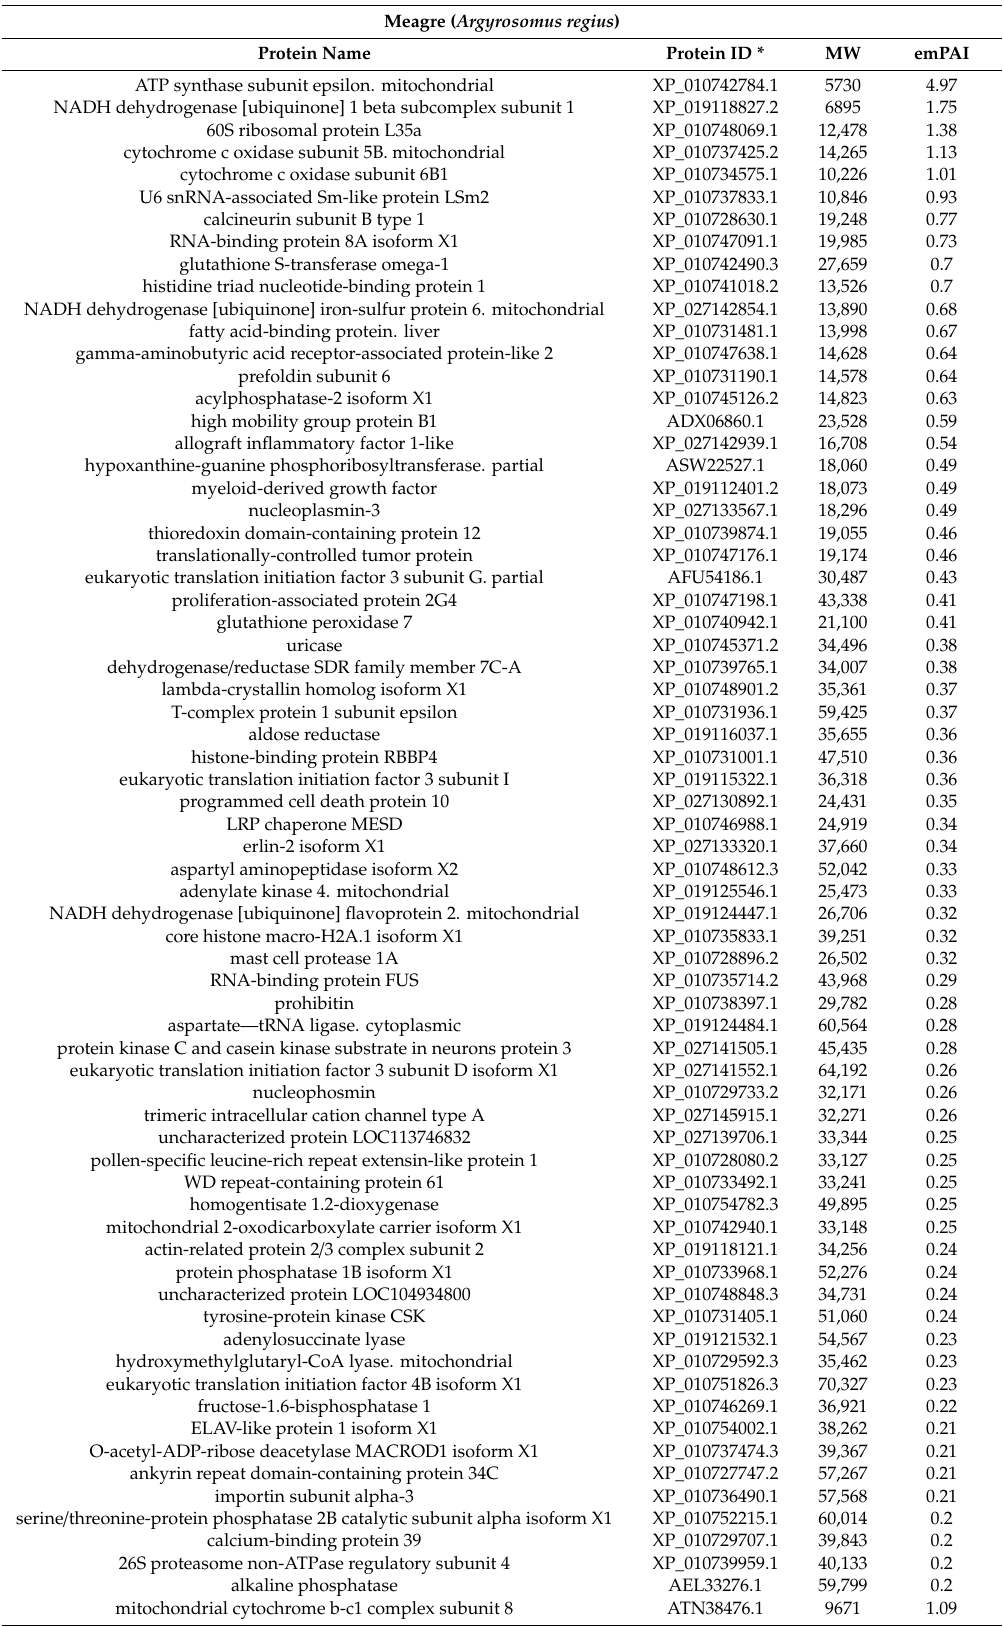
Table 5. Protein profile data of meagre and gilthead sea bream fish by-product samples. Meagre ( Argyrosomus regius